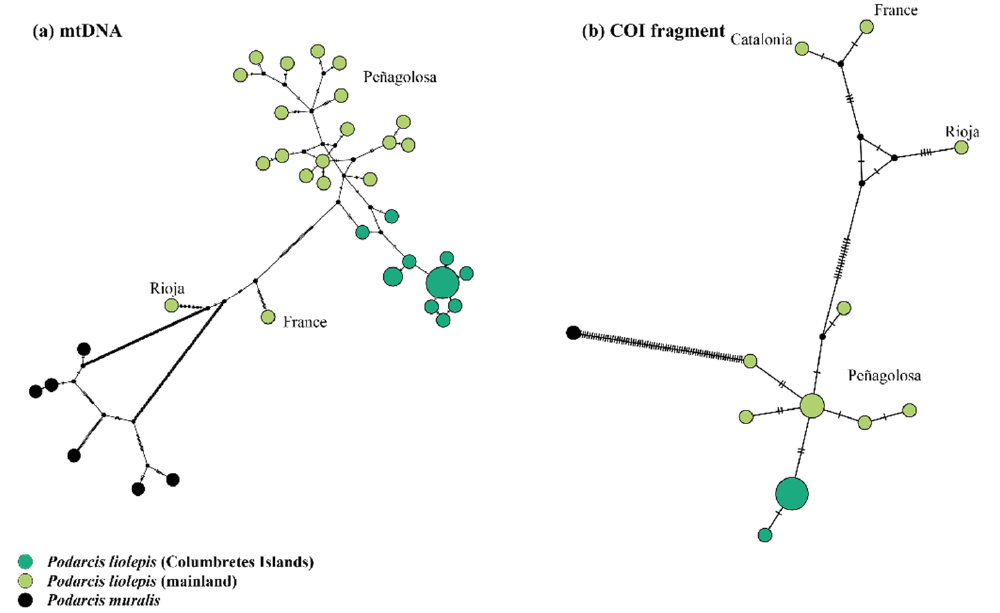
Figure 3. TCS haplotype networks of P. liolepis samples from the Columbretes Islands and the mainland of the Iberian Peninsula for mtDNA alignment ( a ) and for COI mtDNA fragment ( b ). Podarcis muralis was included as an outgroup; black nodes are the inferred intermediate haplotypes. This pattern was more evident in the analyses based on mtDNA, both for phylogenetic trees (ML and BI) (Figure 4) and TCS (Figure 3), than the patterns shown by nuclear genes (Figure 5), indicating that the P. liolepis population from the Columbretes Islands shares some haplotypes with the conspecific mainland population, confirming the genetic proximity between Columbretes and Peñagolosa